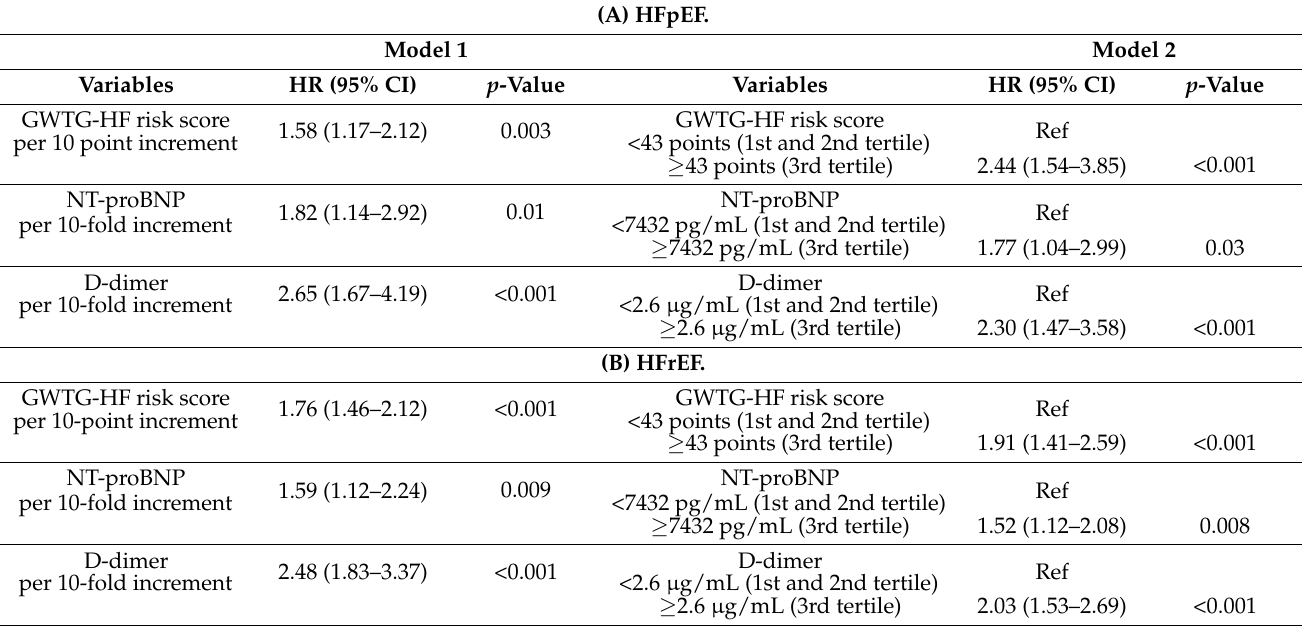
Table 5. Multivariate predictors of cardiovascular mortality in HFpEF (A) and HFrEF (B) patients.